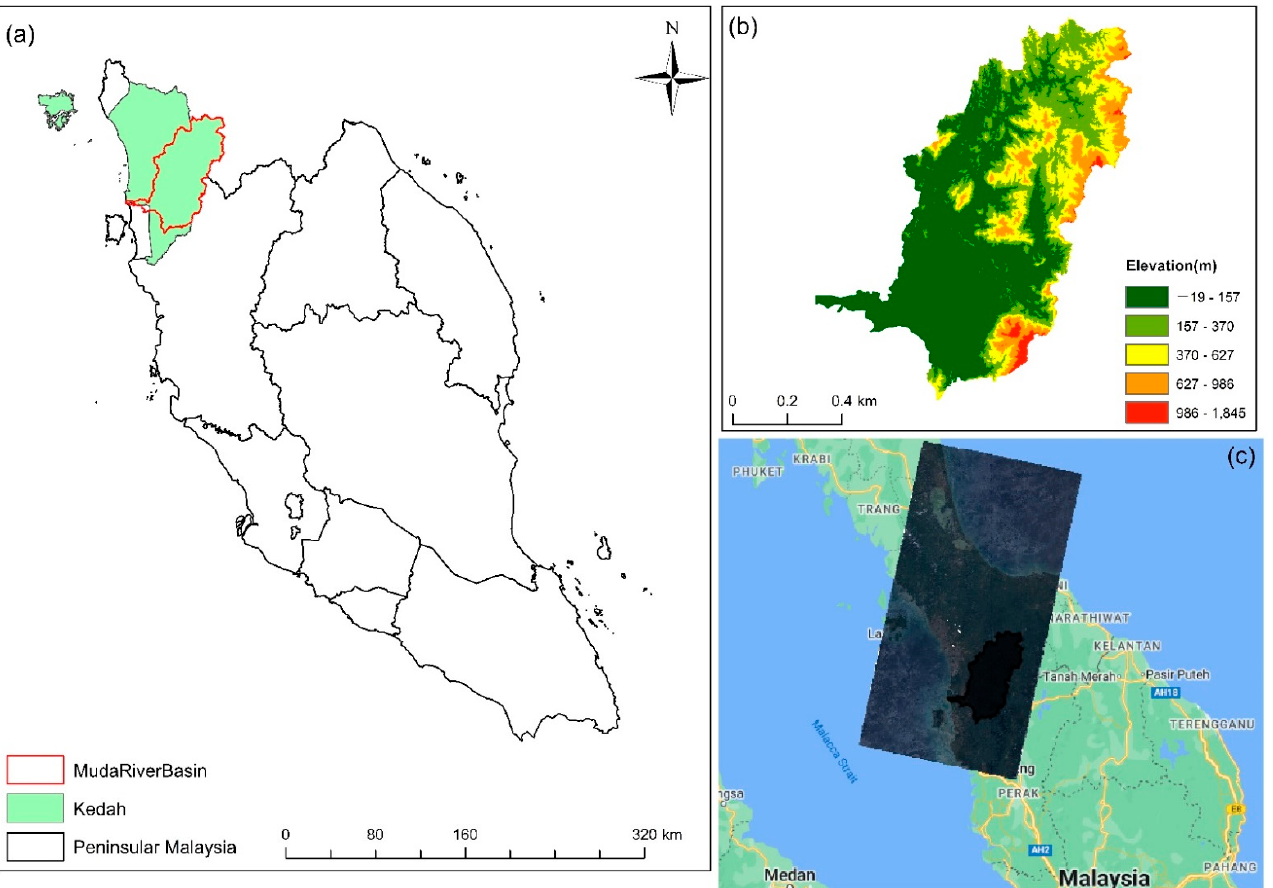
Figure 1. Study area. ( a ) location map of MRB in Peninsular Malaysia; ( b ) elevation map of MRB; ( c ) Landsat 8 image covering MRB.